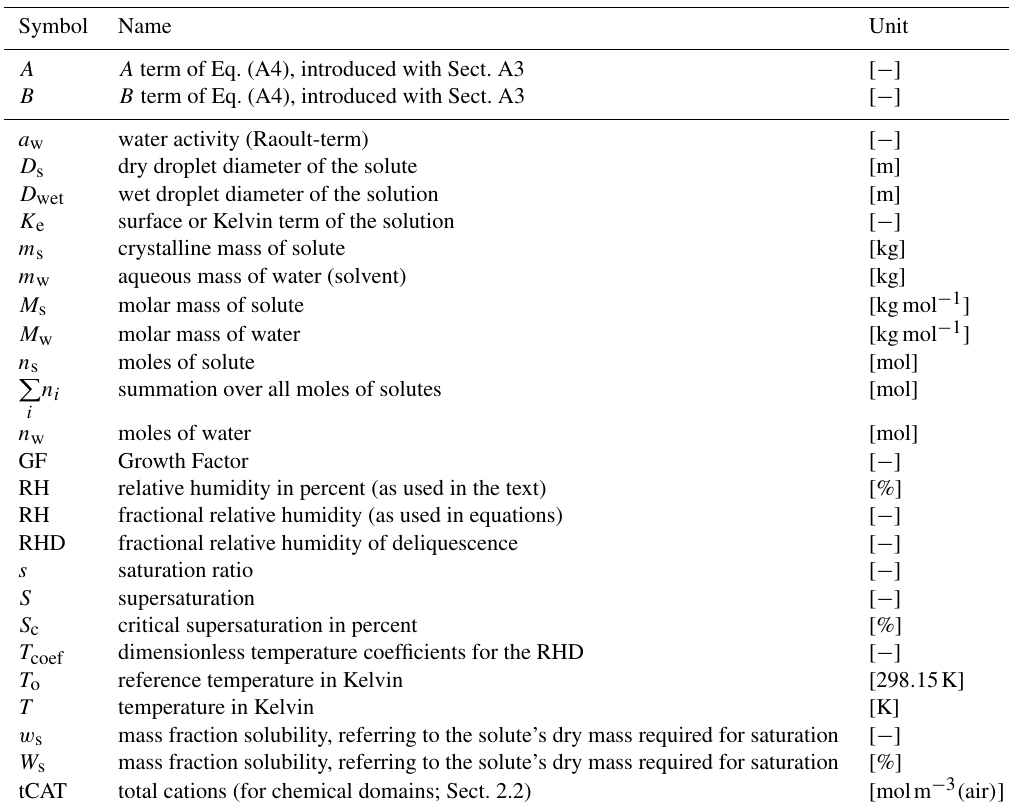
Table A3. List of